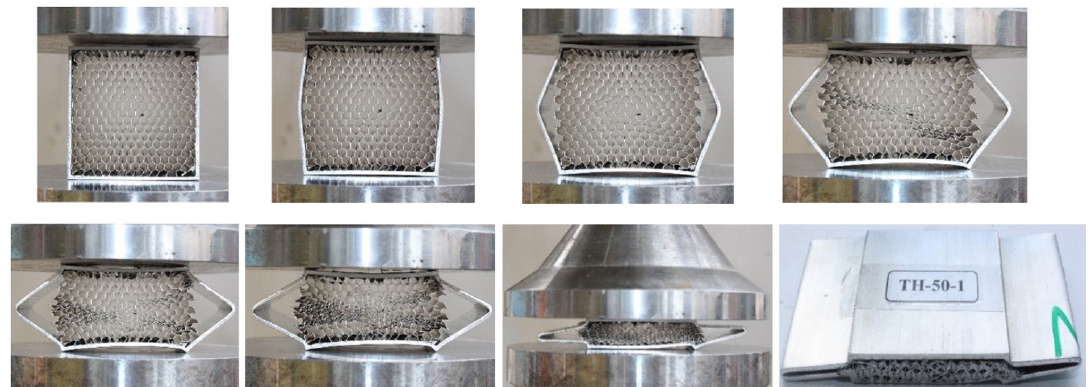
Figure 8. Stages of failure mode of a tube filled with honeycomb laterally